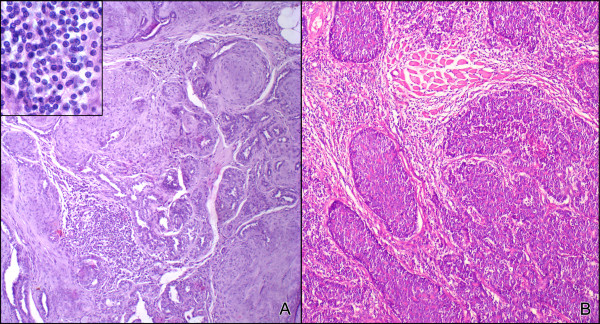
Histological diagnosis of canine mammary carcinoma samples. Low-power view of tumor specimen classified as carcinoma in benign mixed tumor (MC-BMT) associated with multifocal lymphocytic infiltrate, 200× (A); Higher power view of infiltrating lymphocytes in MC-BMT 600× (A-Inset); Low-power view of tumor specimen classified as mammary carcinoma (MC) in solid type associated with diffuse lymphocytic infiltrate, 200× (B). Histological sections (4 μm) underwent hematoxylin-eosin (HE) staining.